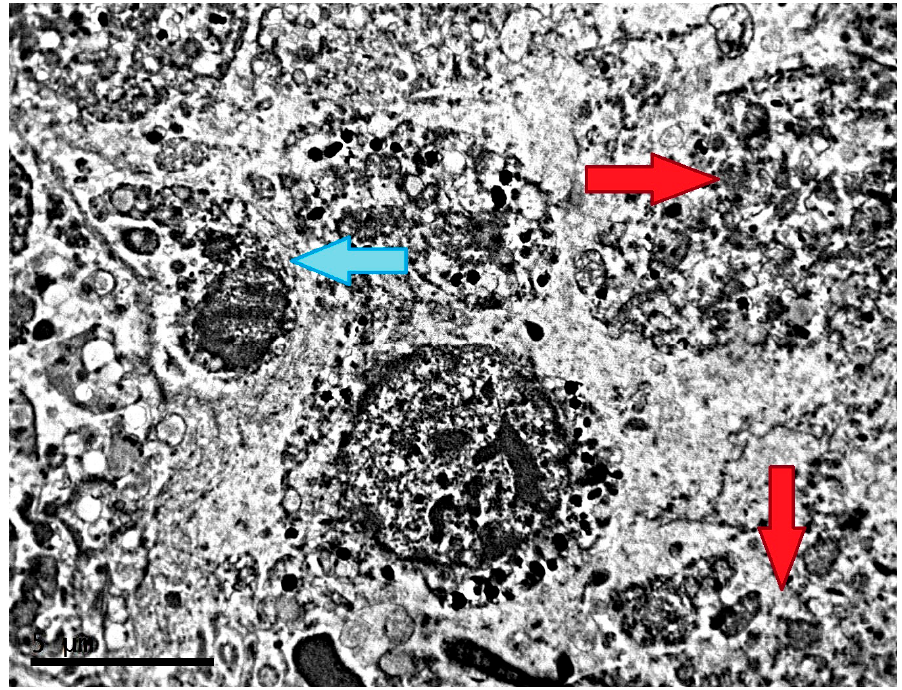
Figure 5. Cell death in transplantable malignant melanoma B16 under the influence of fixed light regime. Blue arrow—apoptosis (shrunken organelles and remnants of nuclear chromatin are visible), red arrows—necrosis. TEM, ×8000.